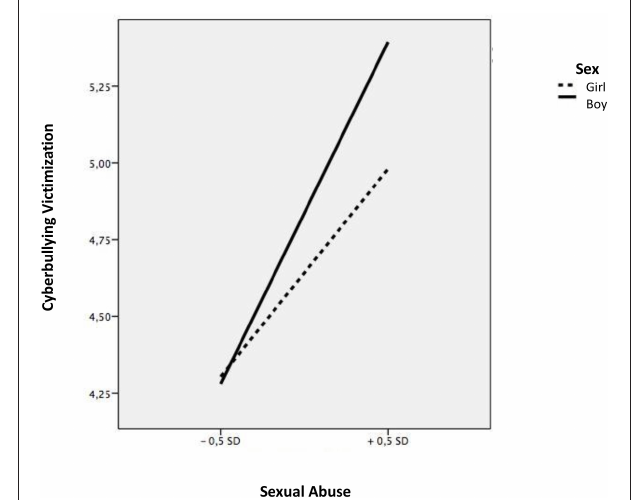
FIGURE 1 | Interaction between sexual abuse and sex in relation to indirect victimization.